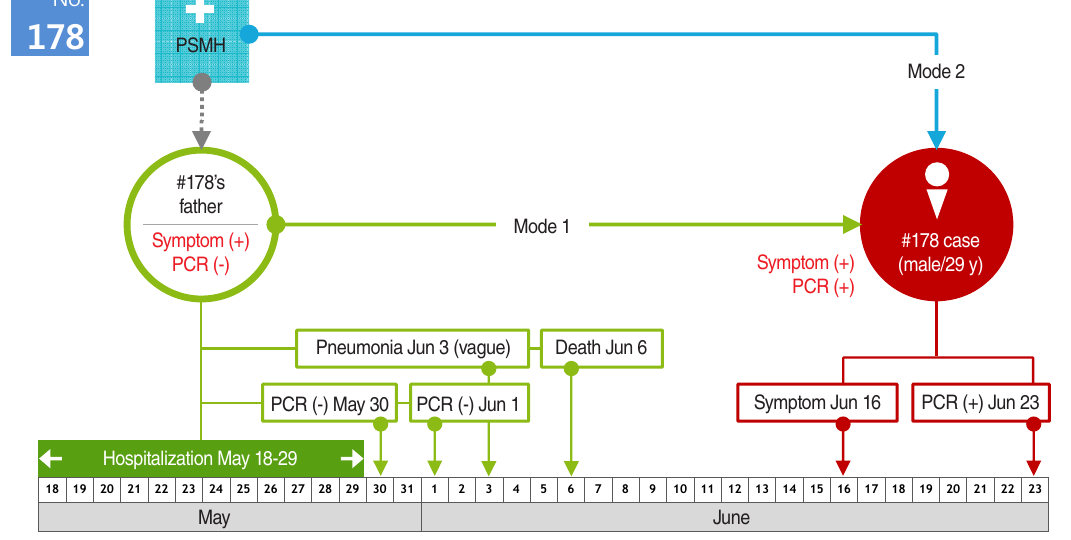
Figure 1. Main events by date for the 178th MERS case in